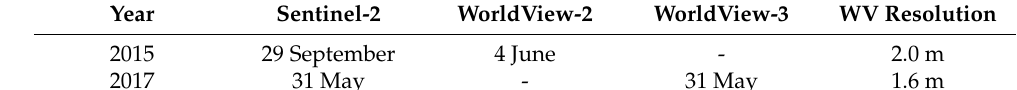
Table 8. WorldView and Sentinel-2 pairs for Maspalomas (Gran Canaria, Spain).